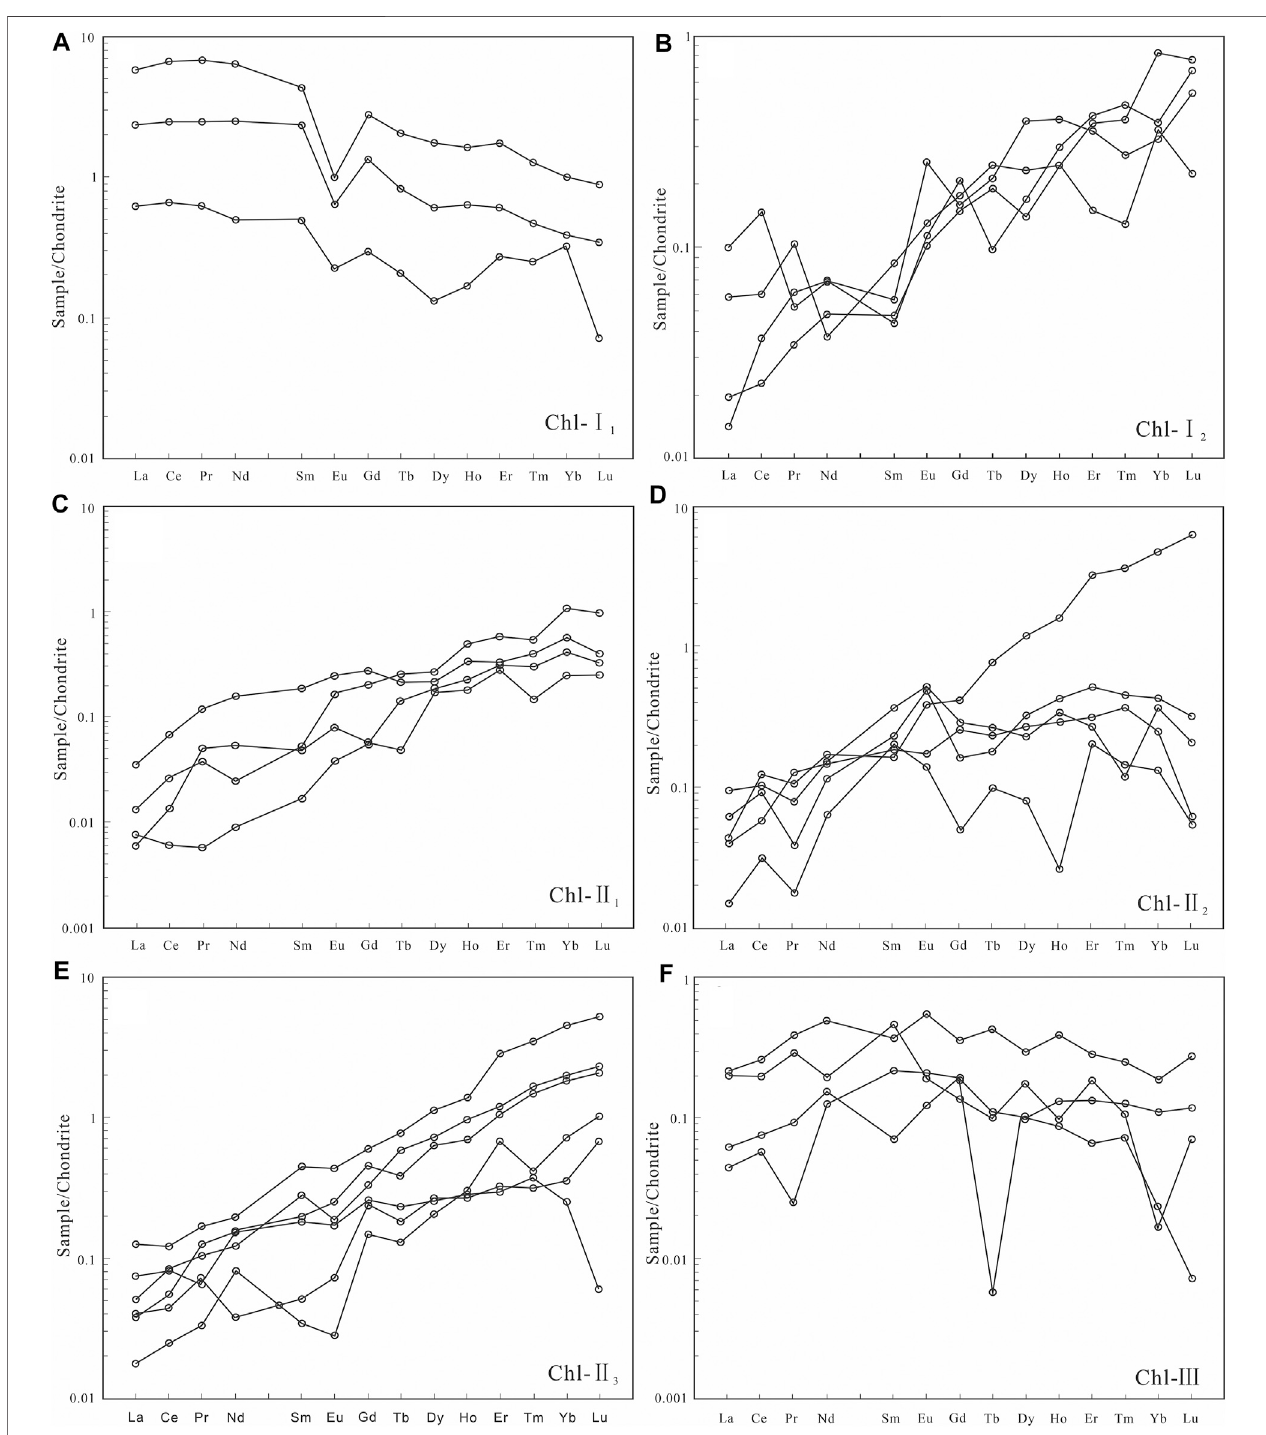
FIGURE9 | Chondrite-normalized rare earth element patterns ofchlorite from different mineralization stages ofthe Tuwu porphyry Cu deposit in eastern Tianshan, Xinjiang, NW China (normalization values from Talor and McLennan, 1985).